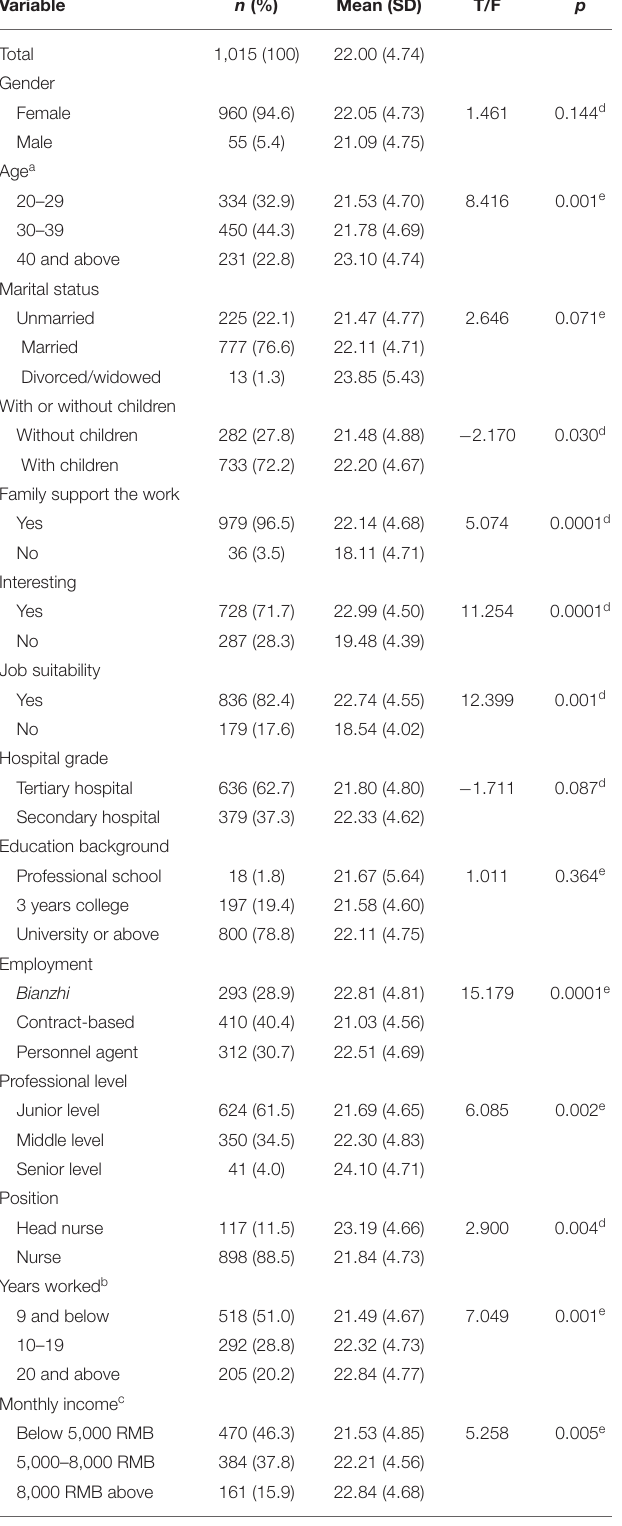
TABLE 1 | Description of the factors of the participants and univariate analysis of Intention to Stay ( n = 1,015). Variable